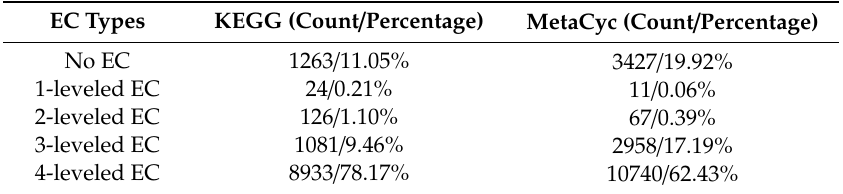
Table 6. Analysis of Enzyme Commission (EC) types involved in reactions in KEGG and MetaCyc.